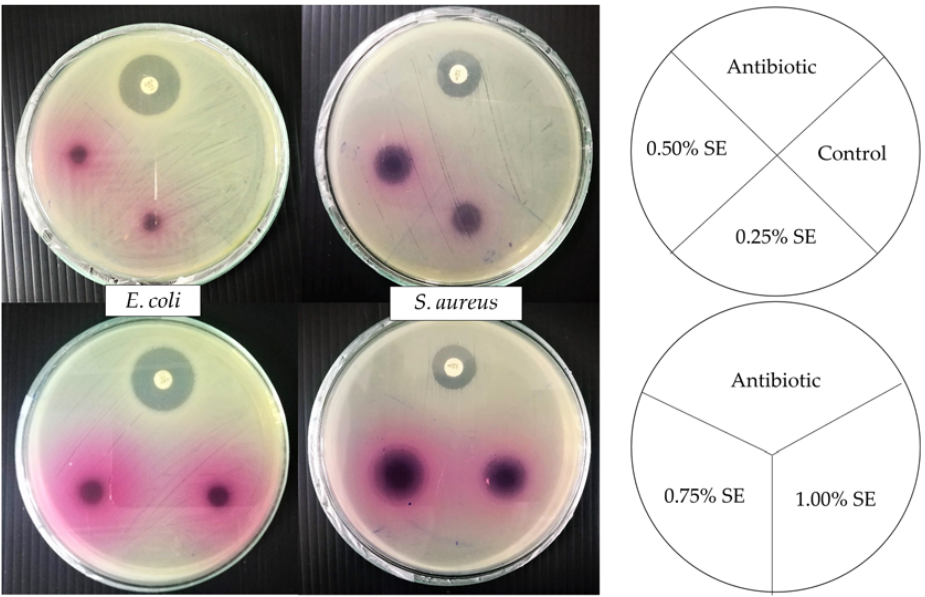
Figure 3 . Antimicrobial activity of gelatin films incorporated with sappan heartwood extract at different concentrations against E . coli . and S . aureus . Numbers denote the concentrations of SE (% , w / v ).